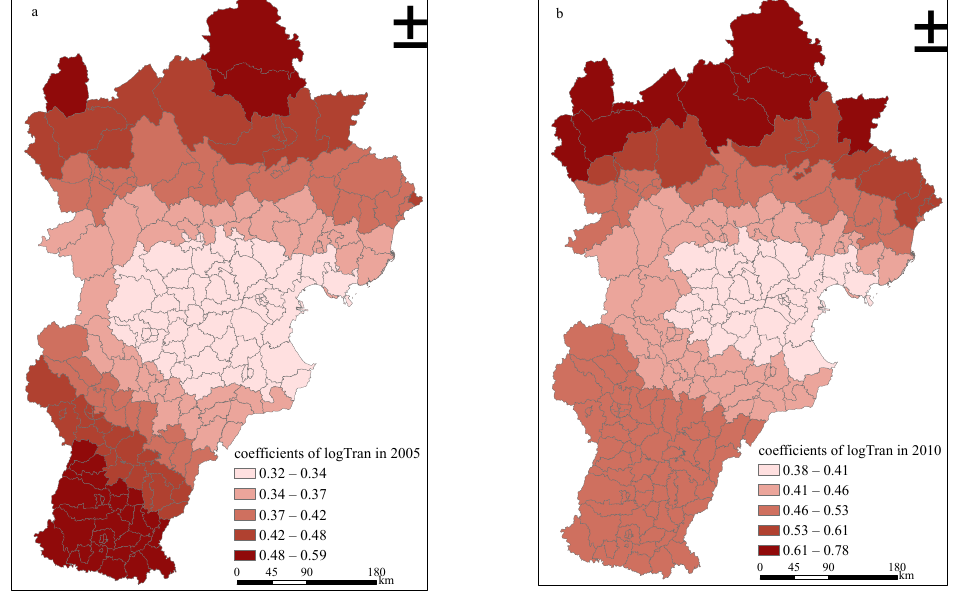
Figure 5. The results of log Tran based on the GWR model in Beijing-Tianjin-Hebei region in 2005 and 2010. ( a ) shows the degree of correlation between urban expansion and PM 2.5 emission from the transport sector in the Beijing-Tianjin-Hebei region in 2005, while ( b ) shows that in 2010.